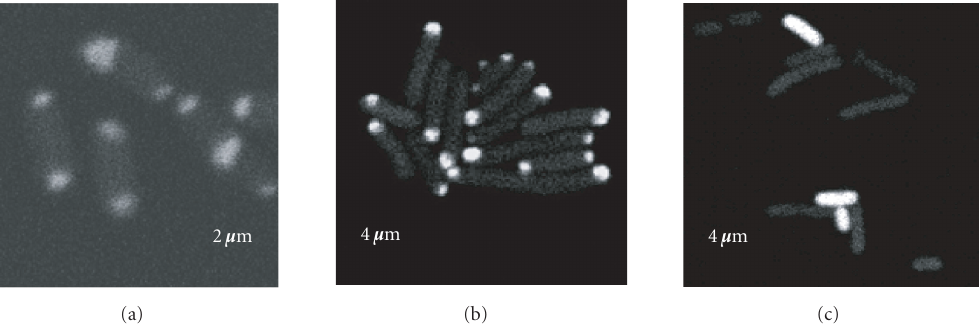
Figure 7: Examples of localization patterns displayed by E. coli cells expressing GFP-fusion proteins. (a) Cells with GFP-fusion protein localization at the poles corresponding to a positive protein-protein interaction. (b) Cells displaying inclusion bodies before induction of the DivIVA-fusion protein. (c) Cells showing cytoplamic GFP-fusion protein localization before induction. Note the visual similarity between the image in (a) and